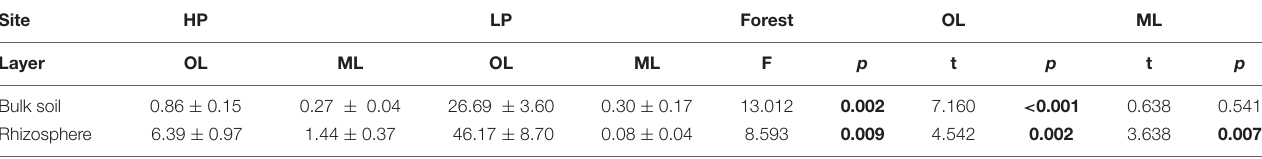
TABLE 1 | Specific activity 33 P in rhizosphere and bulk soil of beech forests. Site HP Forest